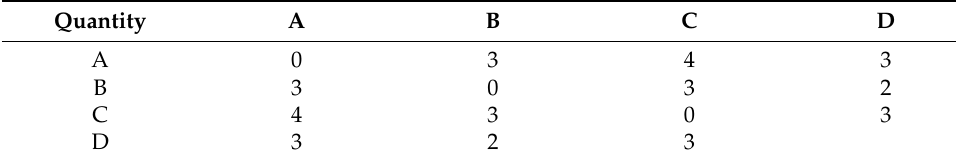
Figure 6. Graph representation of the road network. Table 2. The co ‐ occurrence matrix of Figure 6.